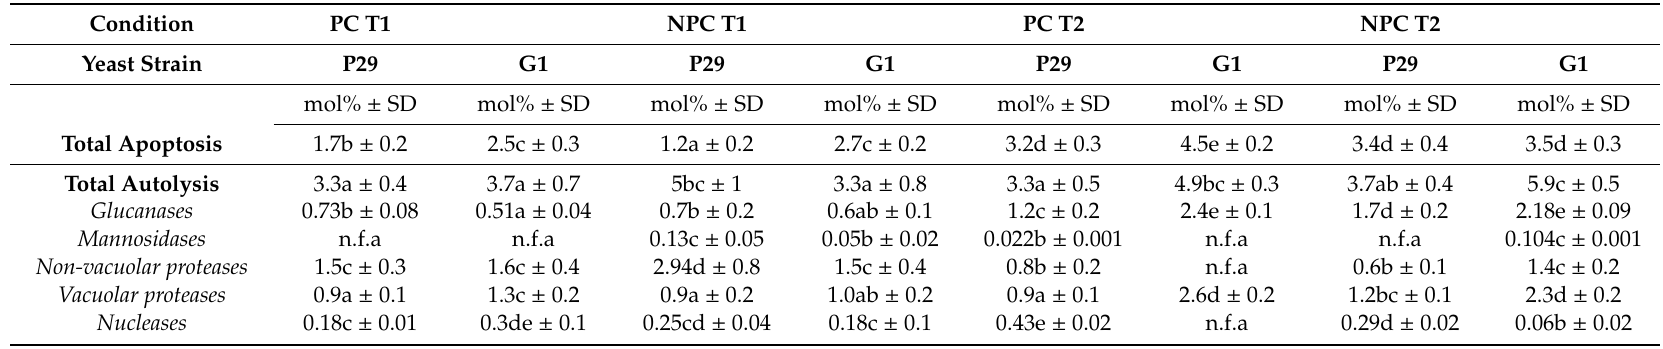
Table 1. Total average value of protein content (mol%) of the proteins related to apoptosis and autolysis identified in S. cerevisiae P29 and G1 under pressure (PC) and non-pressure (NPC) conditions, and in each sampling time: at the middle of the secondary fermentation (T1) and 1 month after it (T2). Total proteome identified so far in S. cerevisiae is provided. A–e Di ff erent letters in a row represent significant di ff erences of protein content in each condition at 0.05 level according to Fisher’s least significant di ff erence procedure. n.f. not